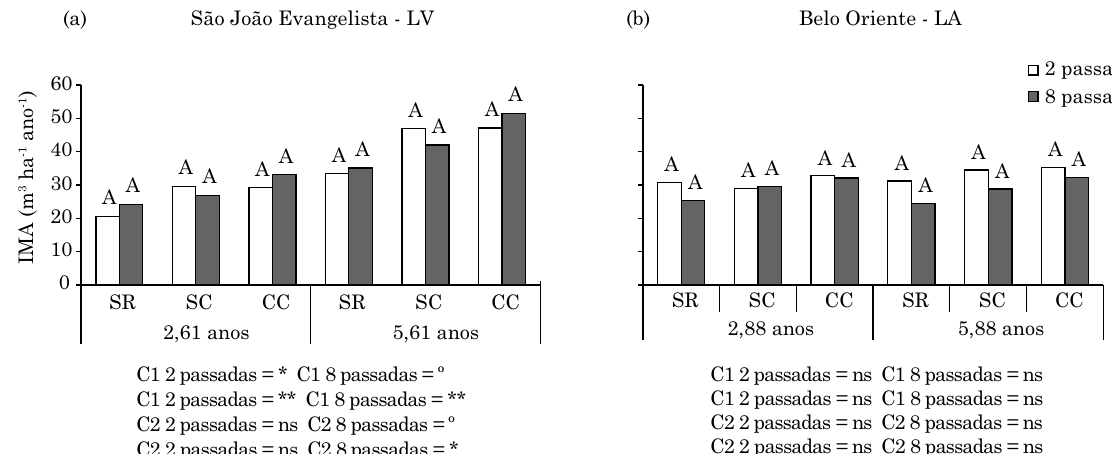
Figura 1. incremento médio anual (iMa) em duas idades após duas ou oito passadas do forwarder sobre resíduo da colheita do eucalipto sem casca (sc); resíduo com casca (cc); e solo sem resíduo (sr) de um latossolo vermelho em são João evangelista, Mg (a); e de um latossolo amarelo na região de belo oriente, Mg (b). c1: sem resíduo (sr) vs com resíduo (sc e cc); c2: resíduo sem casca (sc) vs resíduo com casca (CC). **, *, ° e ns: significativo a 1, 5, 10 % e não significativo até 10 %, respectivamente,